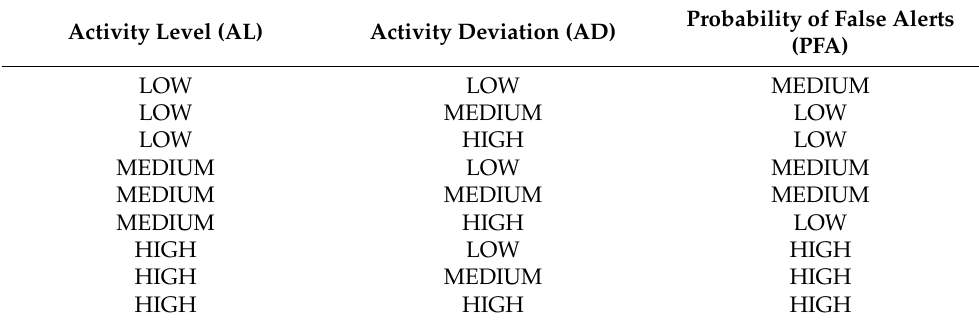
Table 1. The rule base of the fuzzy inference system for filtering false alerts.